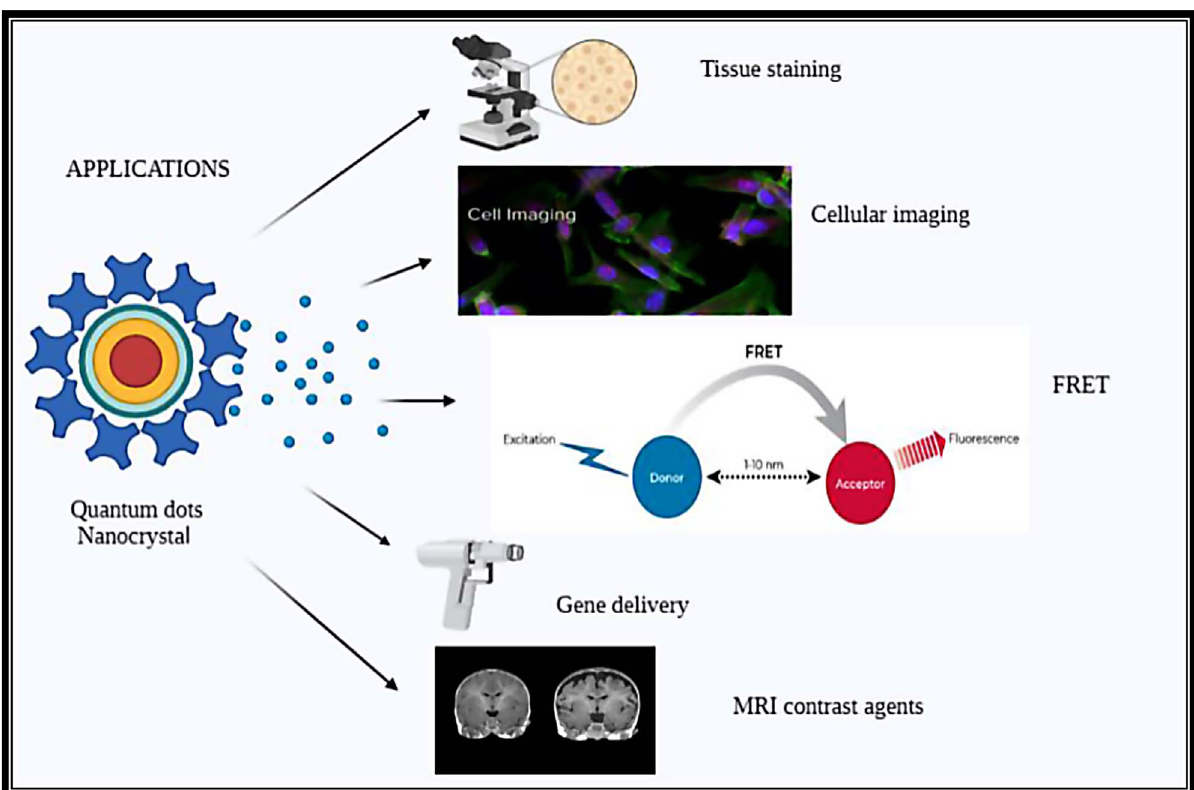
Figure 4. QDs and their